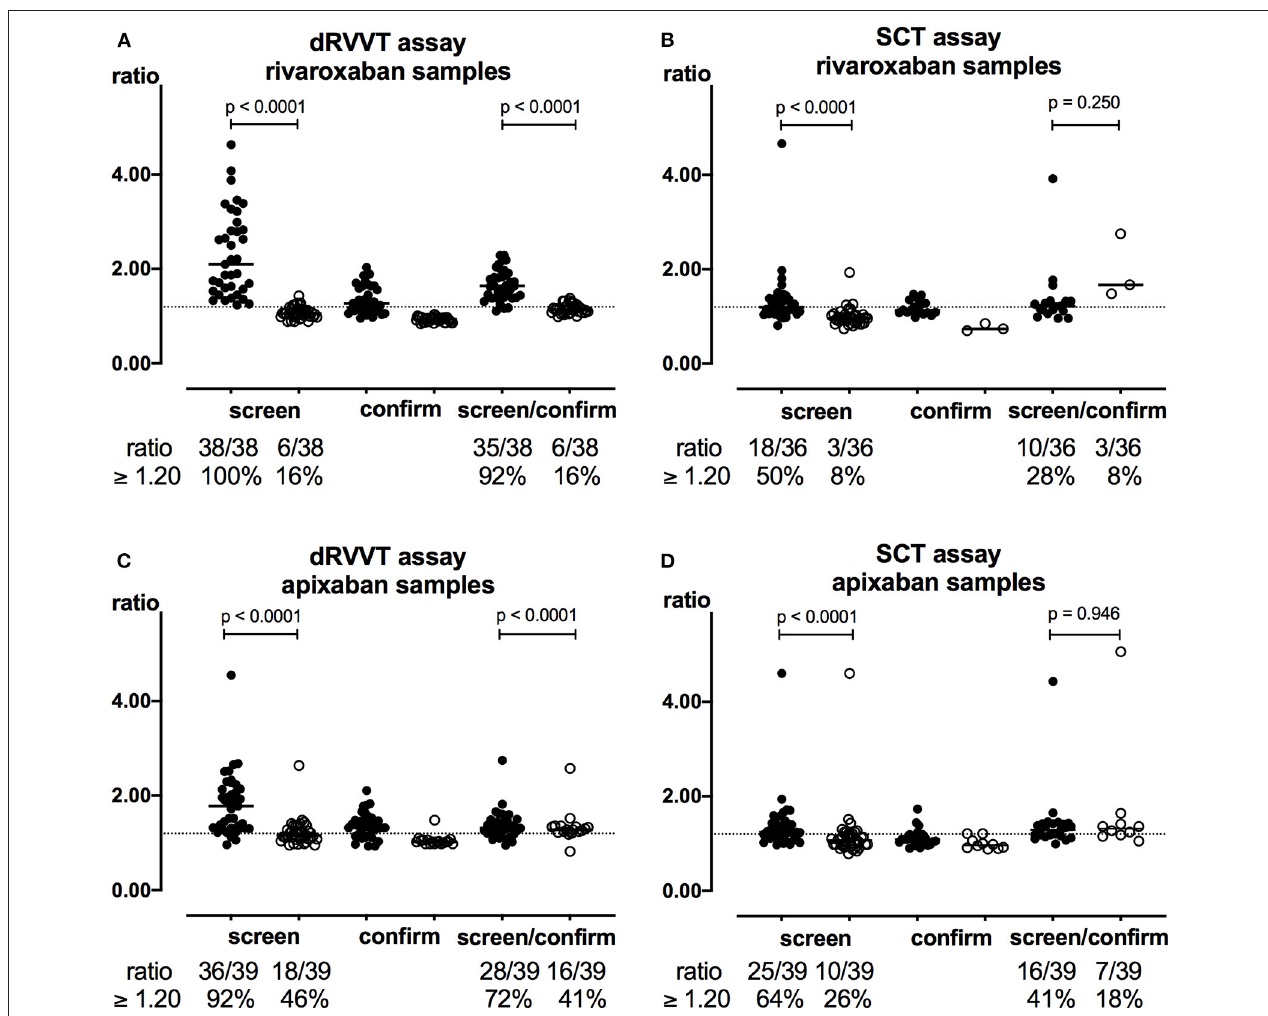
FIGURE 3 | Effect of DOAC Filter on LA testing in FXa inhibitor samples. dRVVT (A,C) and SCT (B,D) screen, confirm, and screen/confirm ratios in rivaroxaban ( A,B , n = 38 and n = 36, respectively) and apixaban ( C,D , n = 39) samples were calculated before (closed symbols) and after (open symbols) treatment with DOAC Filter. Two rivaroxaban samples could not be tested with SCT assays due to insufficient sample volume. Only samples having elevated screen ratio (i.e., ≥ 1.20) were subsequently analyzed using confirm assays. Dashed line corresponds to the cutoff value of 1.20. Horizontal lines represent median values.